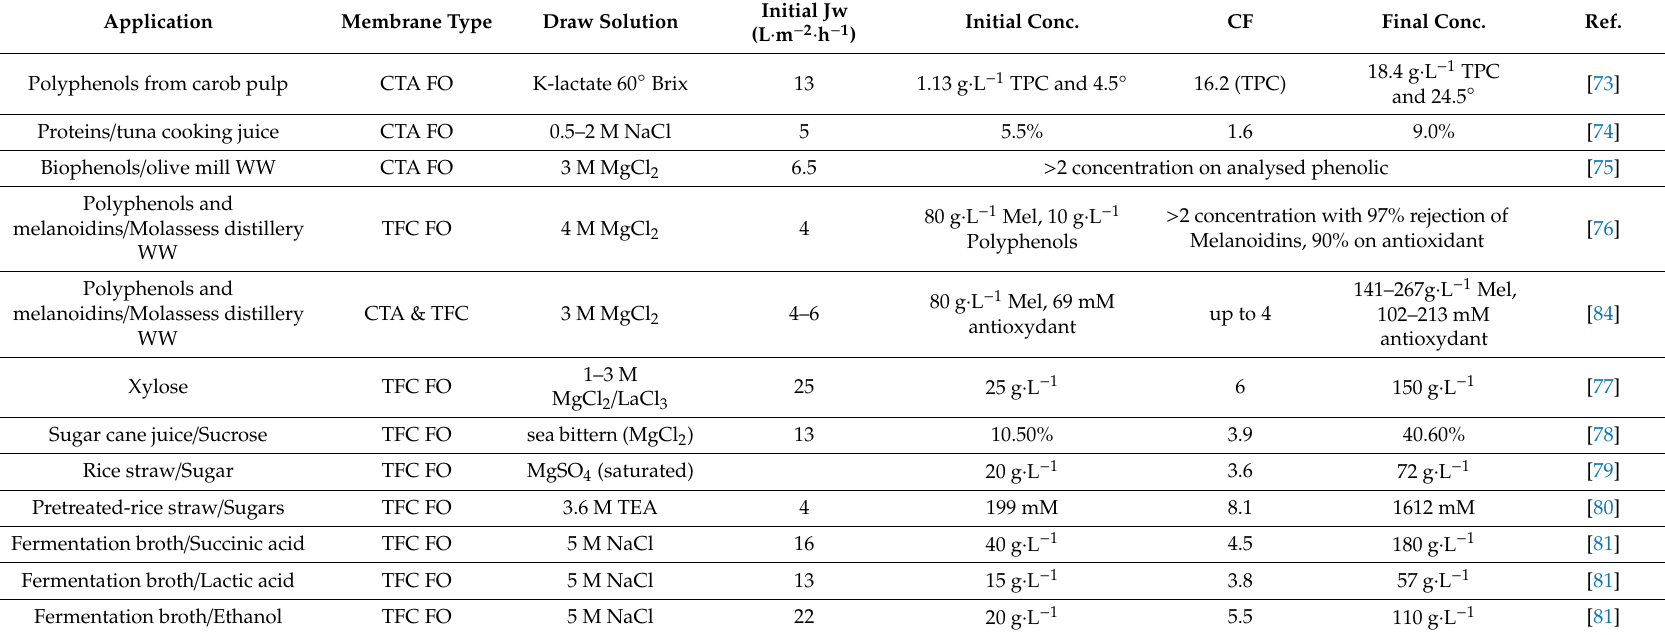
Table 4. FO concentration studies on food derived products and